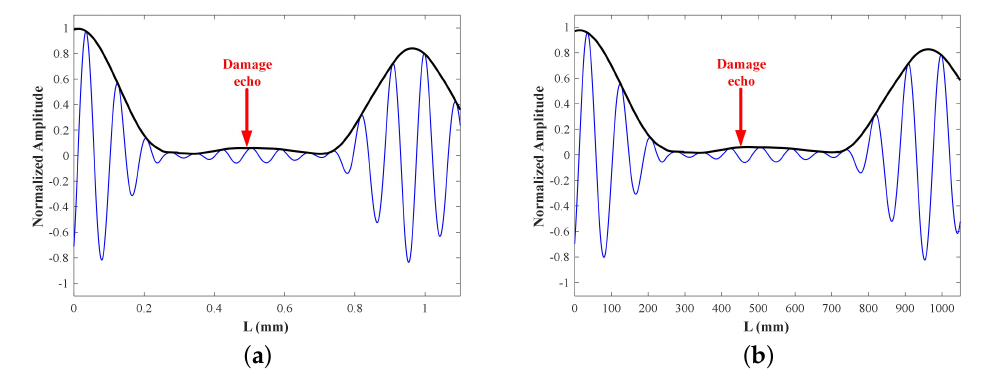
Figure 15. Damage signals from damaged FE model only at 25 kHz: ( a ) #1, ( b )